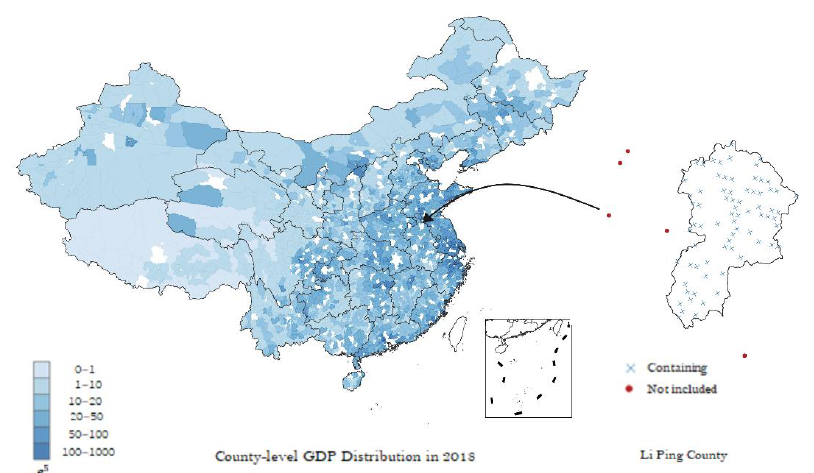
Figure 3. The GDP distribution map of the Chinese Mainland in 2018 (some values along with the boundaries of county-level units are missing), and an example of matching center coordinates and county boundaries. Blue crosses denote center coordinates that fall into the boundary of Liping County, while red points denote centers that do